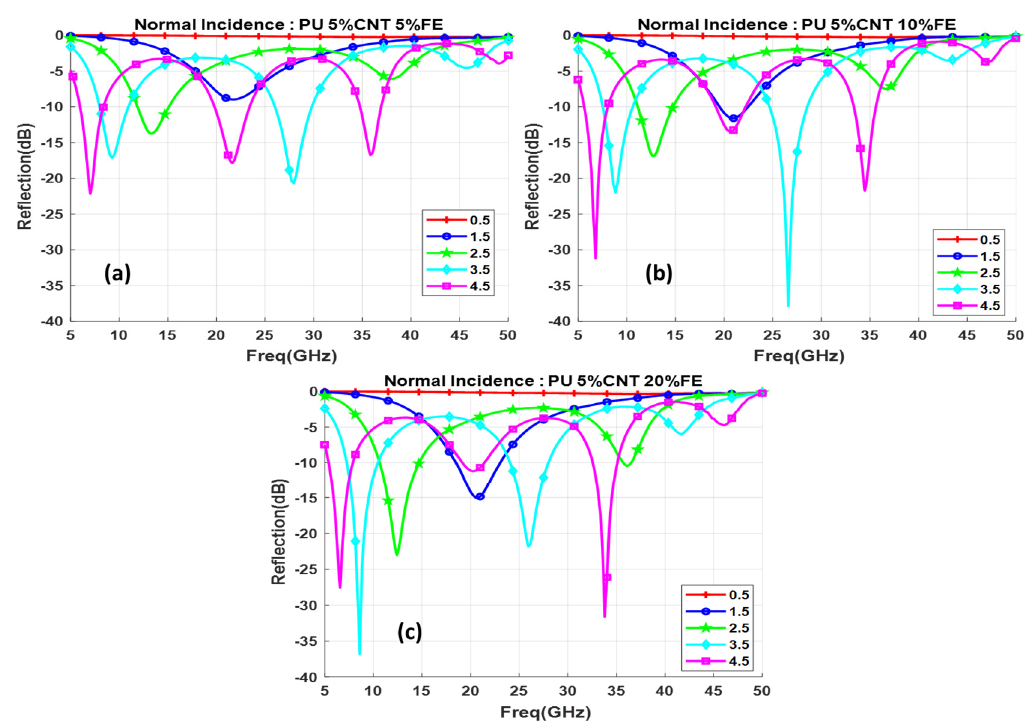
Figure 16. Reflection loss for functionalized composite with different thicknesses (d mm) for ( a ) 5% Fe, ( b ) 10% Fe, ( c ) 20% Fe.